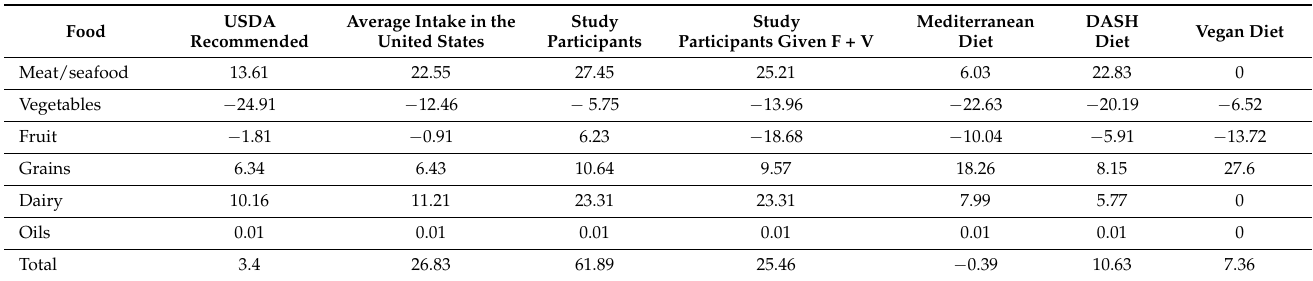
Table 1. Calculated potential renal acid load of selected relevant diets. Used with permission of the American Society of Nephrology, from The continuum of acid stress, Wesson, D.E., 16, 2021 of copyright [45].